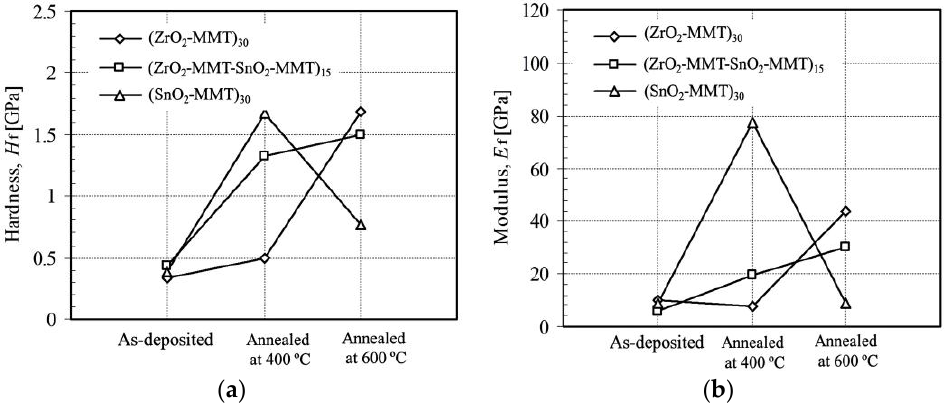
Figure 8. Hardness ( a ) and modulus ( b ) of zirconia-clay multilayers under as-deposited and annealed at 400/600 °C conditions with clay montmorillonite 0.4 wt %.